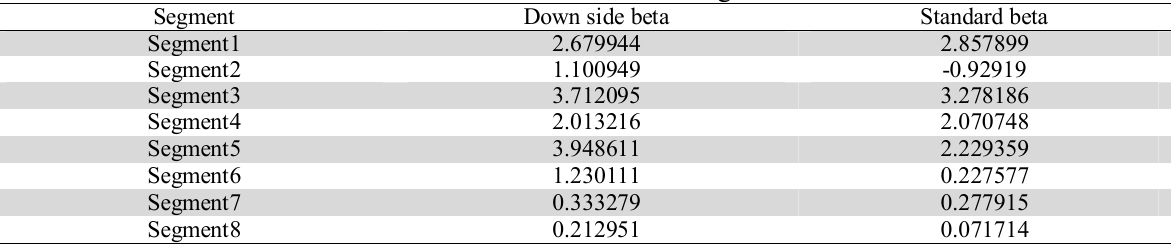
Standard beta Versus Downside beta for different Customer Segments